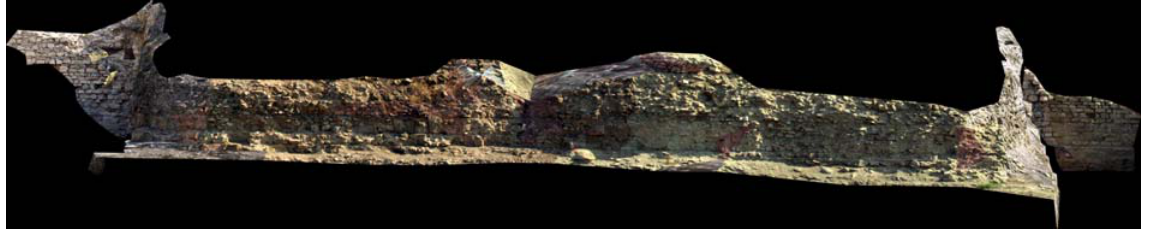
Figure 11. Ortophoto of the southern façade of the Large Tower (ca. 31 meters long), and connections to the curtain, on sides, as resulted from PhotoModeler.